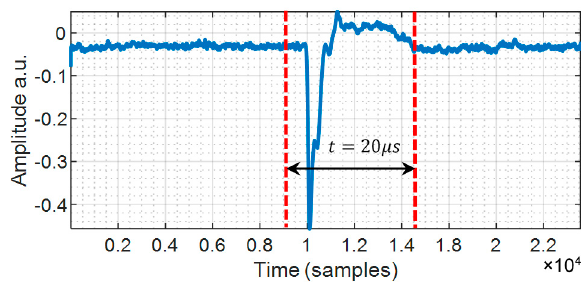
Figure 8. Fast Electric field pulse relevant to a positive NBE. Appl. Sci. 2020 , 10 , x FOR PEER REVIEW